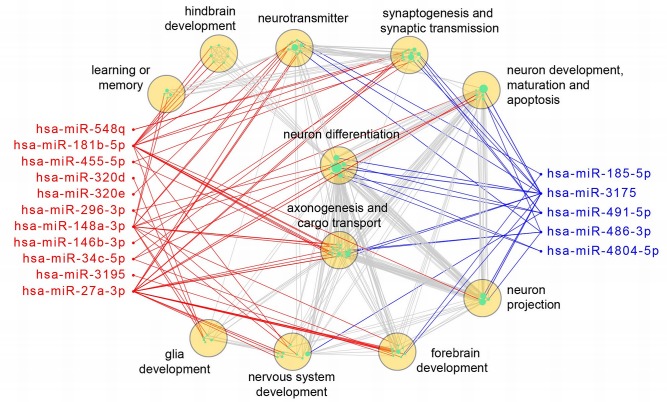
A network view of neurological function of significantly altered miRNAs.Red nodes stand for up-regulated miRNAs, blue for down-regulated miRNAs, and cyan for enriched GO terms (n = 91, with sizes proportional to the numbers of predicted miRNA targets). GO terms were further classified into broader function groups (yellow circles) by QuickGO. A red or blue edge indicates a GO term was enriched in the predicted targets of up-regulated or down-regulated miRNAs, respectively. Grey edges link GO terms with overlapped targets (overlap coefficient > 0.5). This network was created by the Cytoscape 3.2.0.